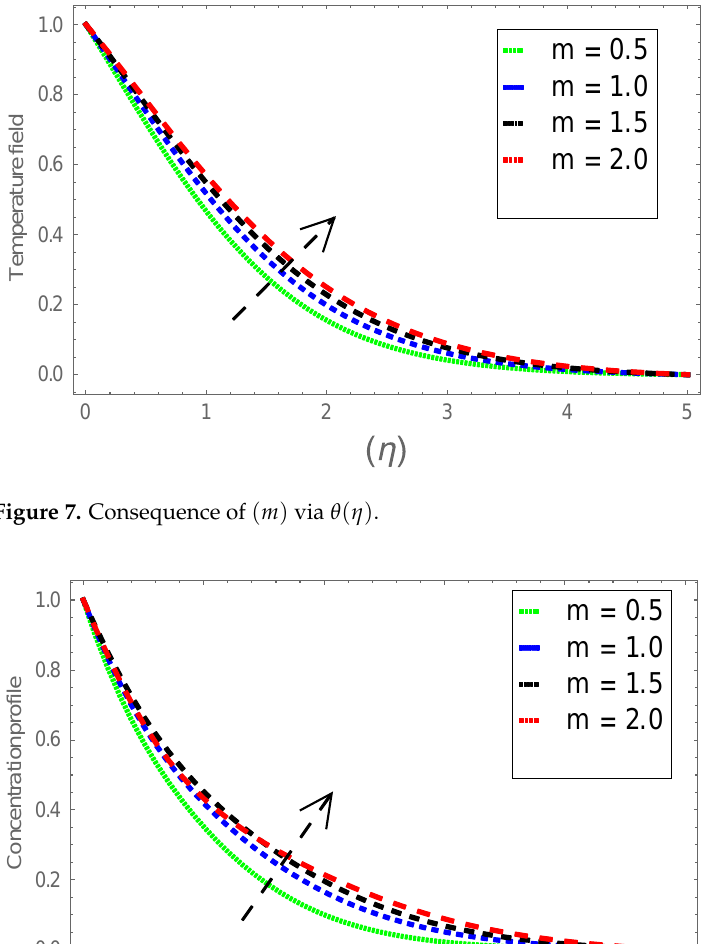
  Figure 8. Consequence of ( m ) via φ ( η ) . Coatings 2021 , 11 , x FOR PEER REVIEW